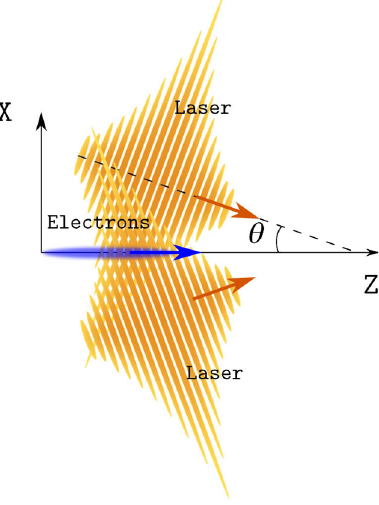
FIG. 1. Optical lattice